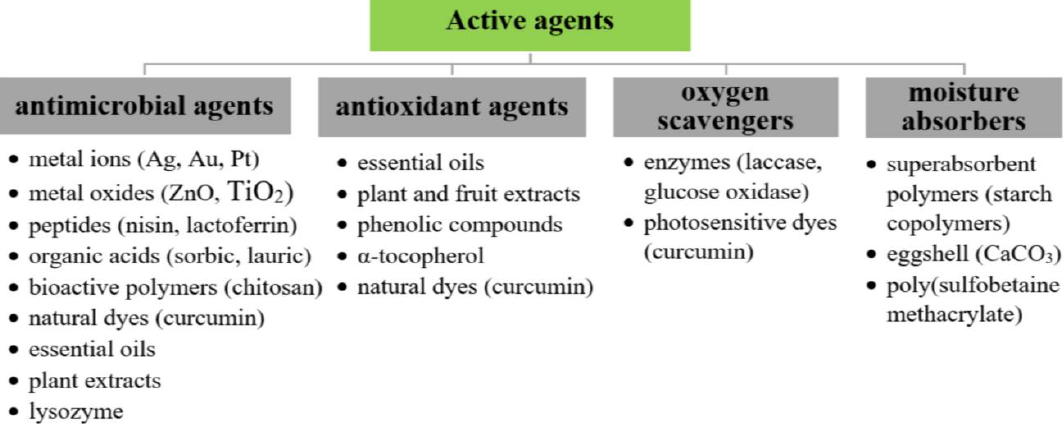
Figure 3. The overview of active compounds applied for BNC active packaging development